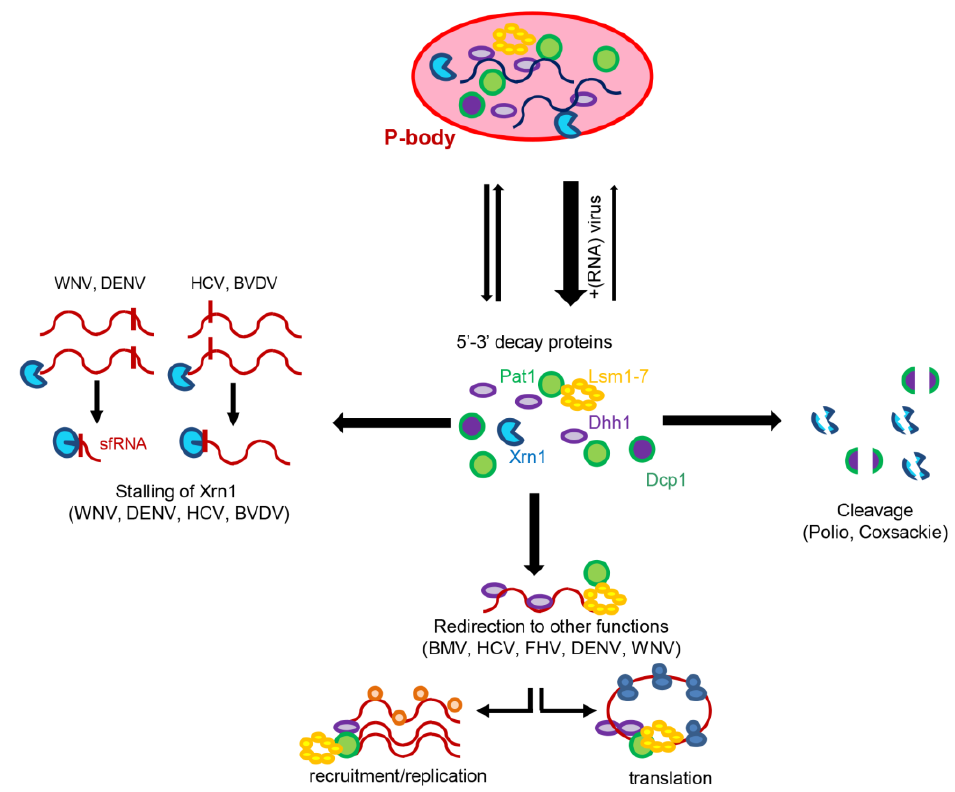
Figure 4. (+)RNA viruses and the cellular mRNA decay machinery. Multiple strategies have been developed by (+)RNA viruses to not only prevent the degradation of the viral RNA genomes but also, to subvert it to their benefit. P-bodies: processing bodies; WNV: West Nile virus; DENV: Dengue virus; HCV: hepatitis C virus; BVDV: bovine viral diarrhea virus; FHV: Flock house virus; BMV: brome mosaic virus.